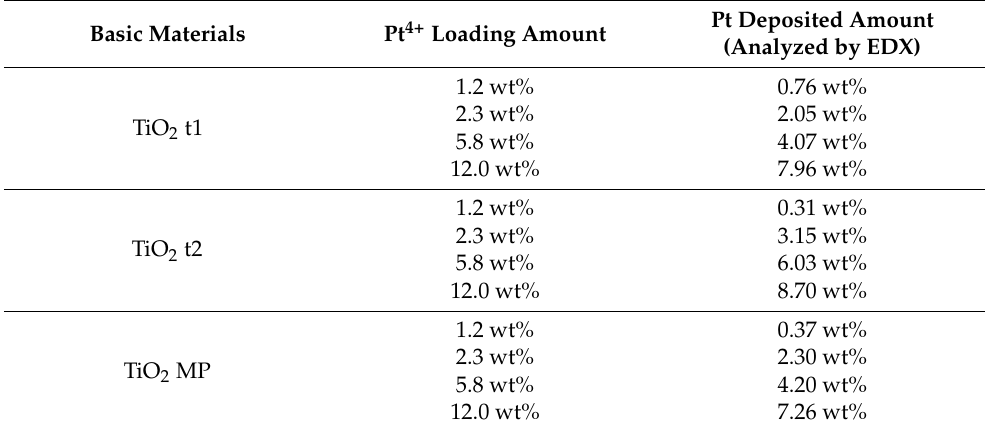
Table 2. Summary of Pt 4+ loading amounts and actual Pt-deposited amounts, analyzed by EDX, for TiO 2 -based materials. Basic